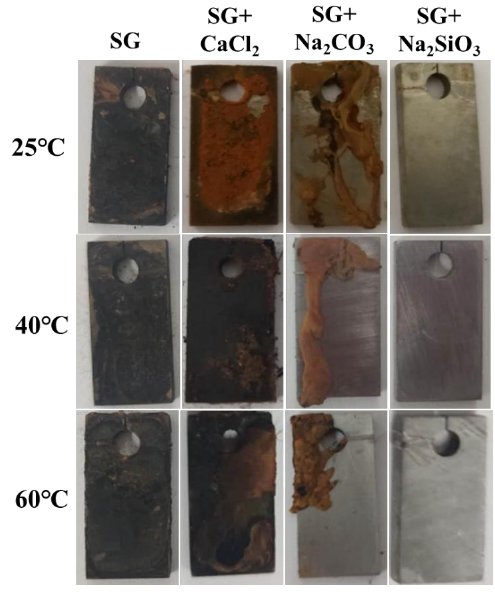
Figure 6. Visual appearance of iron after four weeks immersion in 20 mM SG and SG + CaCl 2 /Na 2 CO 3 /Na 2 SiO 3 solutions.